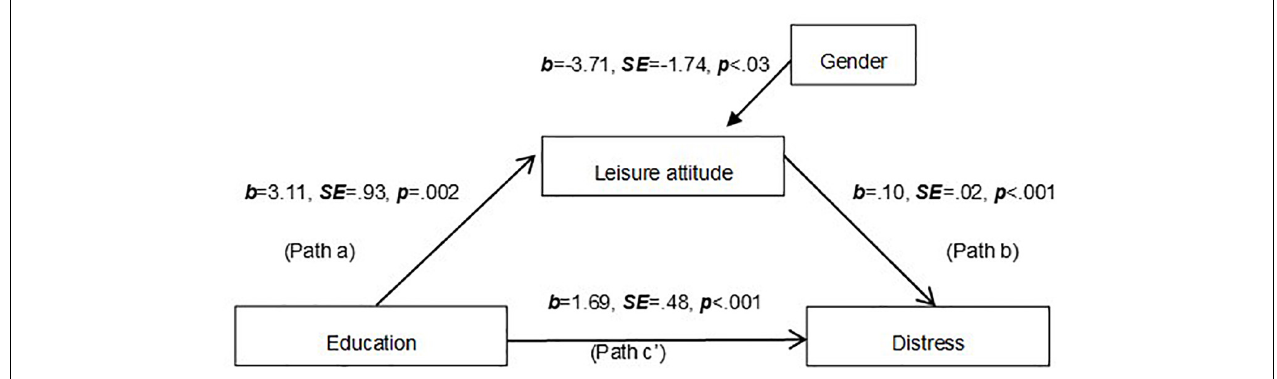
FIGURE 2 | The mediation analysis model including education, leisure attitude, and